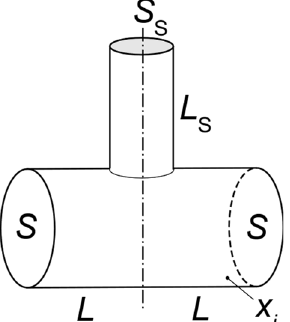
Figure 5. Quarter-wavelength resonator sketch ( left ) and examples of TL obtained with TMM ( center and right ).